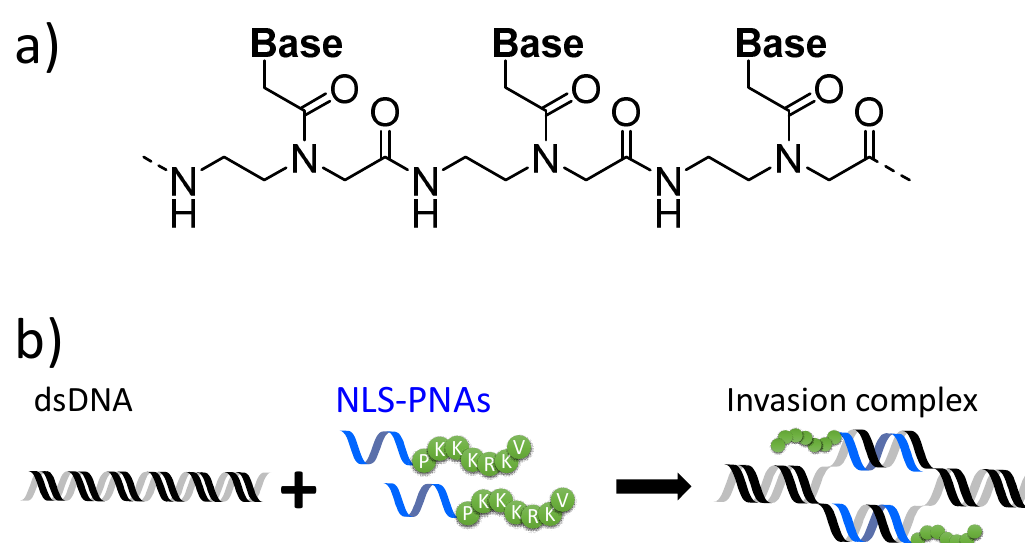
Figure 1. ( a ) Chemical structure of peptide nucleic acid (PNA). ( b ) Stable invasion complex formation using nuclear-localisation-signal-modified PNAs (NLS-PNAs).